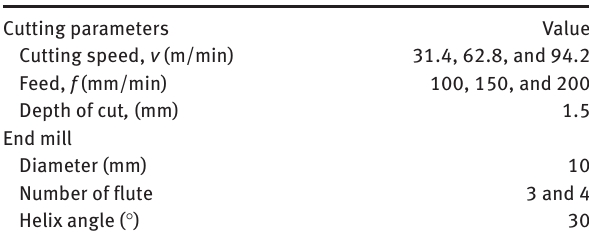
Table 1 Details of cutting parameters and end mill tool.